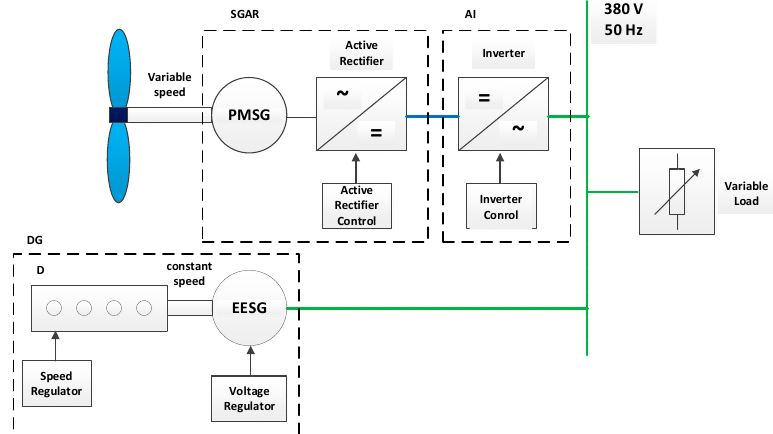
Figure 3. Flowchart of the ship’s mechatronic system with two generators (permanent magnet synchronous generator (PMSG)–electric excitation synchronous generator (EESG)). The voltage at the output of the PMSG changes proportional to its rotary speed.